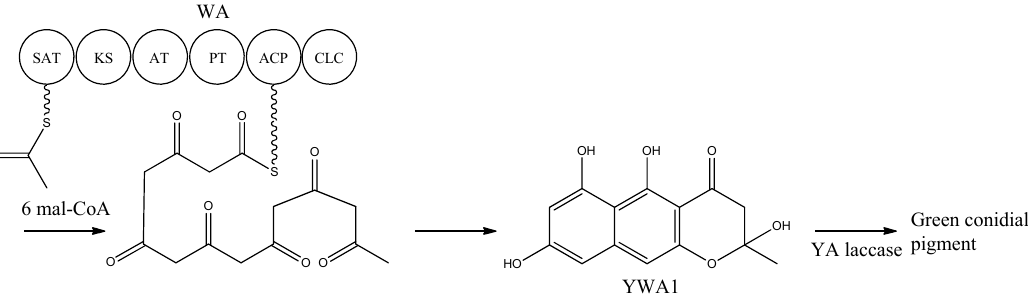
Figure 2. Biosynthetic pathway for formation green conidial pigment in A.